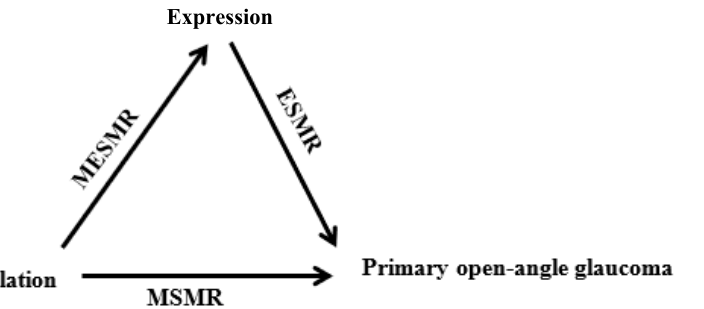
Figure 2. Diagrammatic representation of 3xSMR analysis showing the cascade of causal associations from DNA methylation to POAG development.